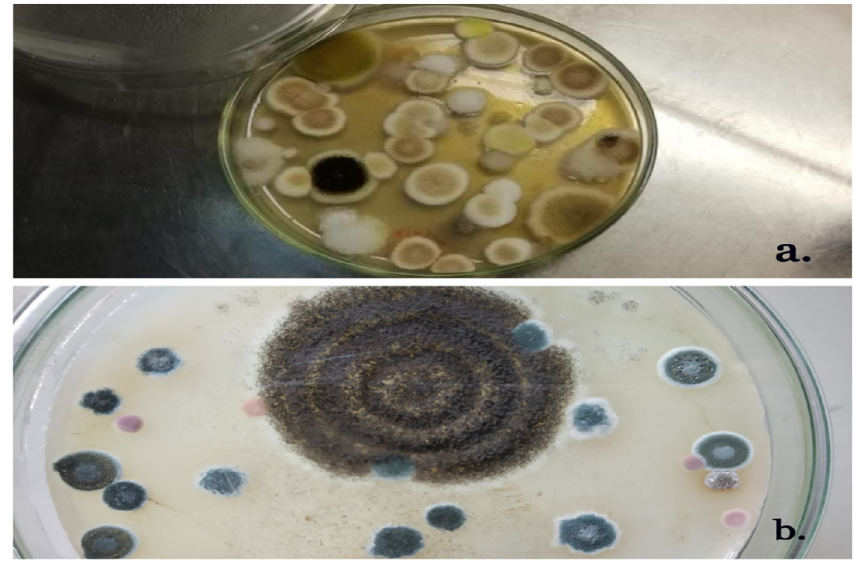
Fig. 2. Primary isolation of actinomycetes from soil a) on AIA, b) on